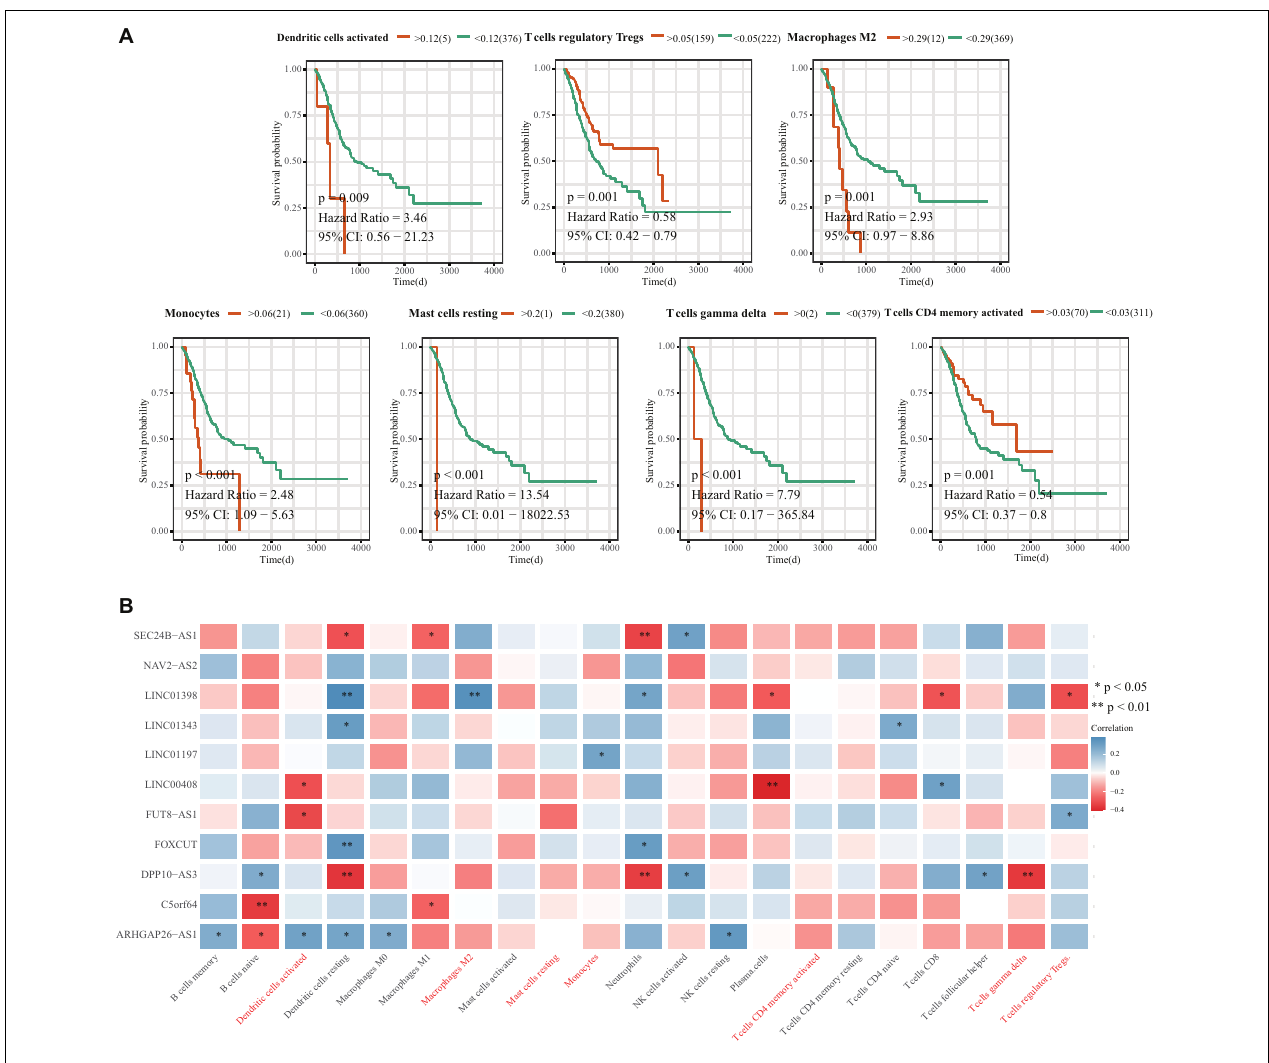
FIGURE 9 | Correlation analysis between the immune-related 11-lncRNA signature and prognosis-related immune cells. (A) Kaplan-Meier survival analysis of immune cell infiltration and ES prognosis. (B) Heat map of correlations between the 11-lncRNA signature and prognostic immune cells. The ordinate is the gene name, the abscissa is the immune cell type, and the color represents the correlation coefficient; ∗ p < 0.05, ∗∗ p <